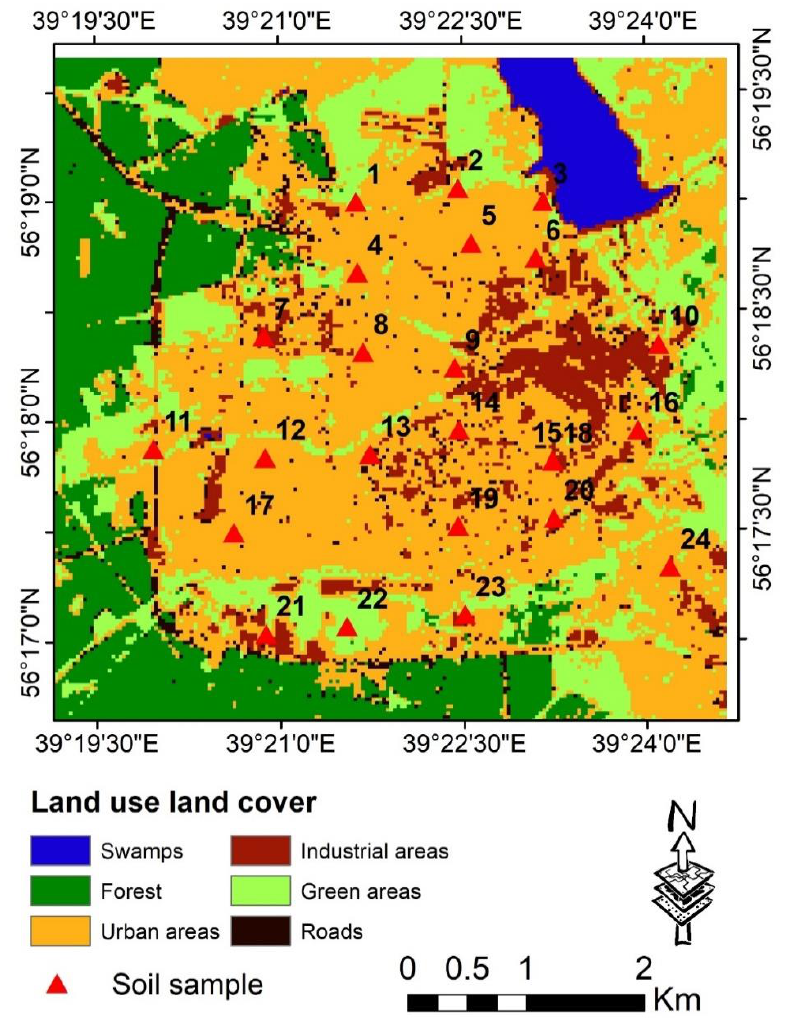
Figure 9. Distribution of land-use/land-cover map illustrating six classes. The findings of LULC were linked with the pollution load index (PLI). Comparing the outcomes of (LULC) and (PLI), it was found that the maximum value of (PLI) is 982 and the minimum value is 49.6 for locations 16 (industrial area) and 3 (urban area),